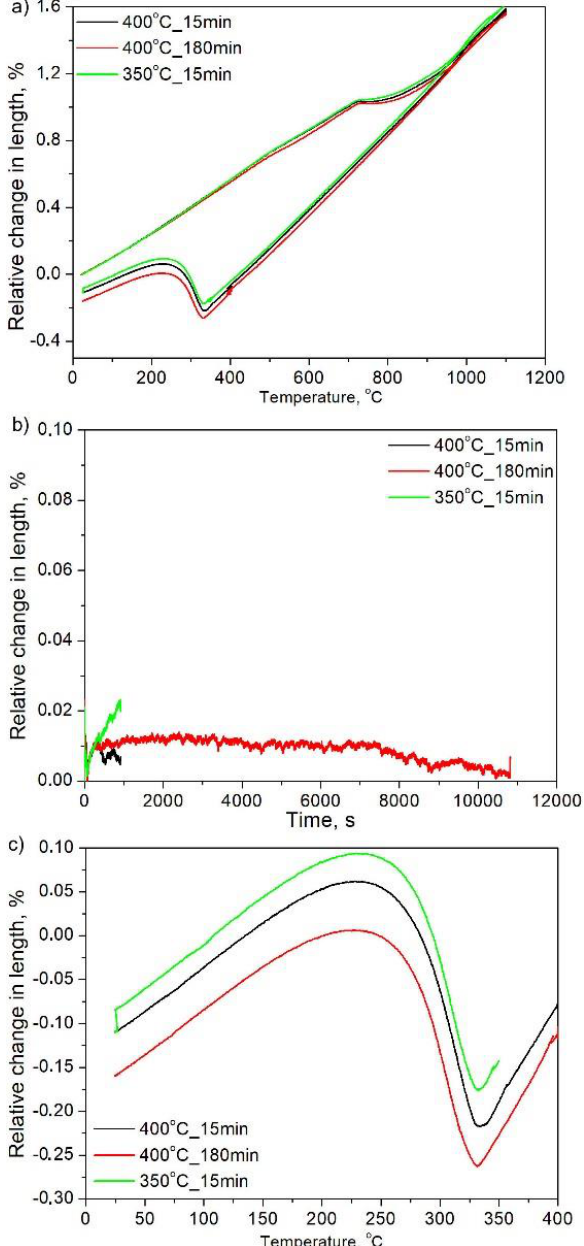
Figure 4. Dilatometric curves of steel during isothermal bainitic transformation: ( a ) full curves; ( b ) during isothermal holding; ( c ) during cooling to room temperature.